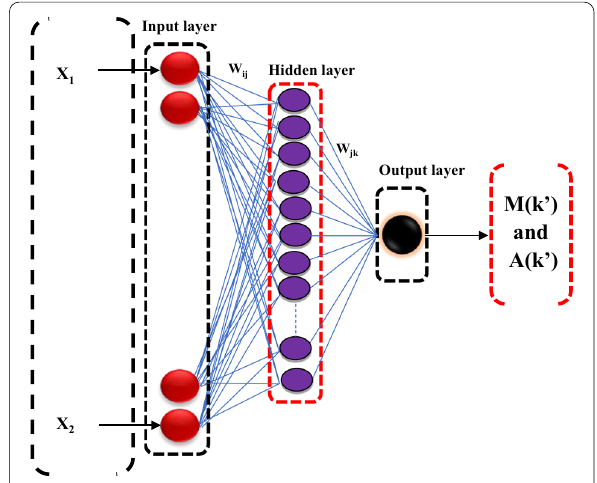
Fig. 2 Three-layer multi-layer perceptron structure